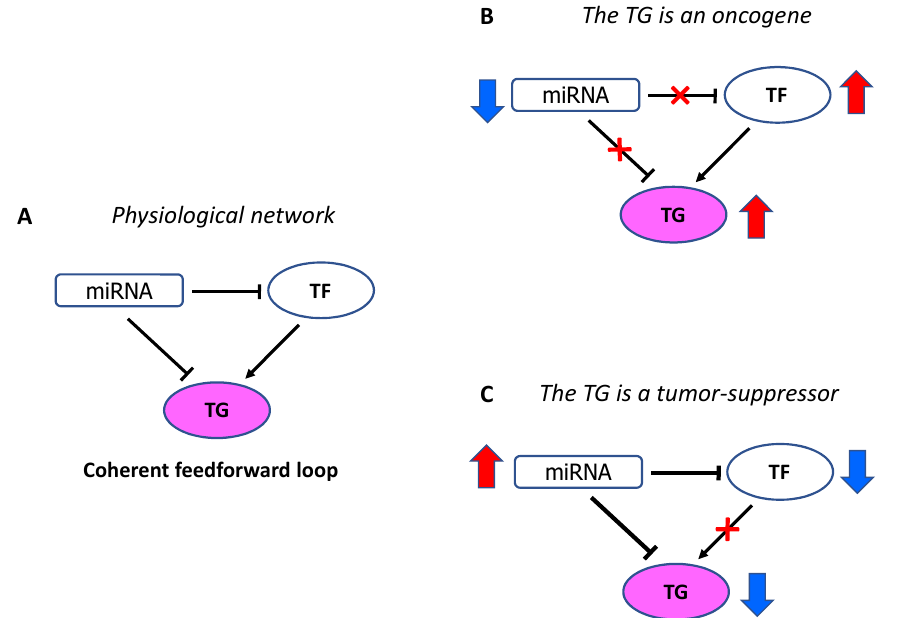
Figure 2. Schematic representation of the most common miRNA ‐ TF ‐ TG feedforward loop disrupted in cancer. One of the most common coherent feedforward loops (see Figure 1(Ba)) frequently disrupted in cancer, especially in NB ( A ) may generate an enhanced oncogene activation when the target gene (TG) is an oncogene ( B ) or a decreased tumor ‐ suppressor function when the TG is a tumor ‐ suppressor (TS) gene ( C ).